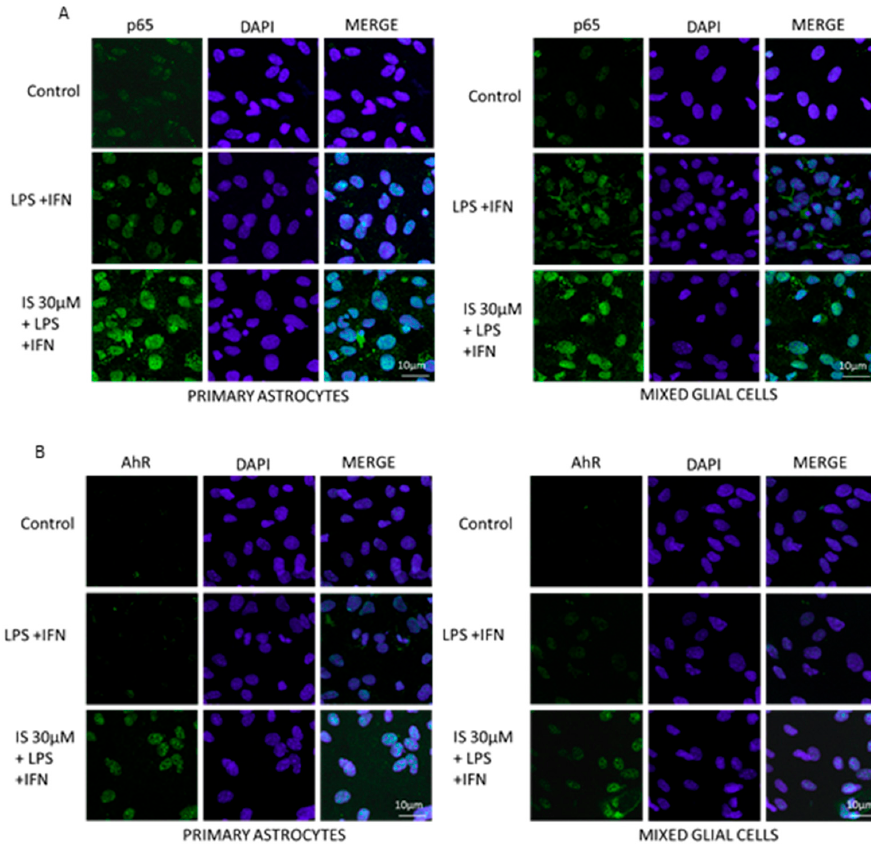
Figure 5. Effect of IS (30 µM) on p65 ( Panel A ) and on AhR ( Panel B ) nuclear translocation in astrocytes and mixed glial cells in inflammatory conditions, induced by LPS (1 µg/mL) + IFN (100 U/mL). Nuclear translocation of p65 and AhR was detected using immunofluorescence confocal microscopy. The scale bar was 10 µm. Blue fluorescence indicated the localization of the nucleus (DAPI) and green indicated the localization of p65 or AhR.